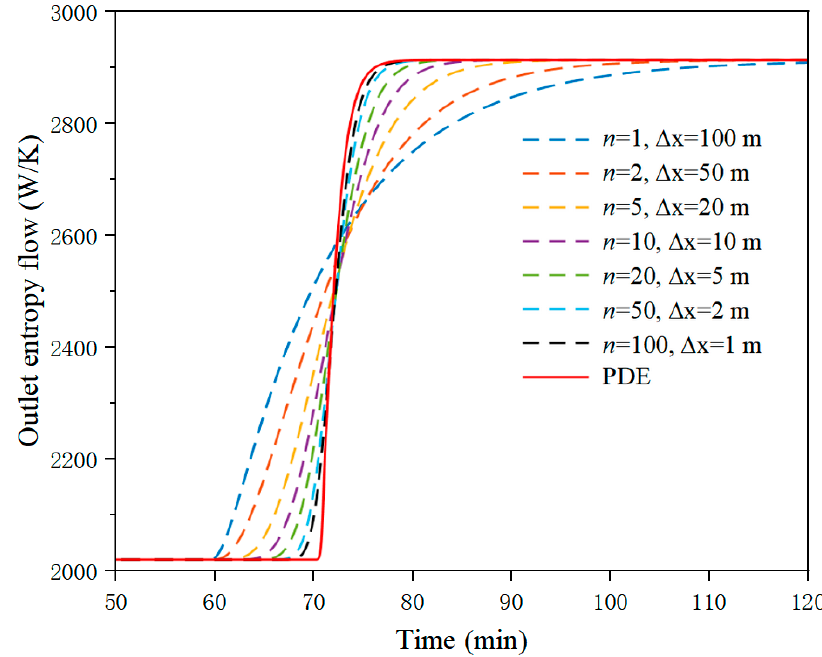
Figure 8. Response of outlet entropy flow under different discretization.